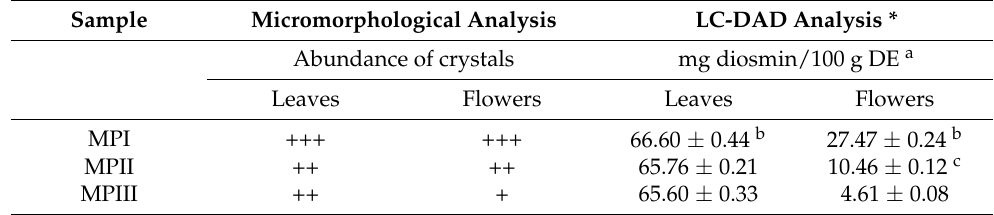
allow for clear quantification of differences in diosmin content between the samples. A comparison between microscopic analysis and diosmin chemical determination is shown in Table 1. Table 1. Comparison between micromorphological and phytochemical analyses of the diosmin content of M. pulegium leaves and flowers of plants collected in three different Sicilian locations: